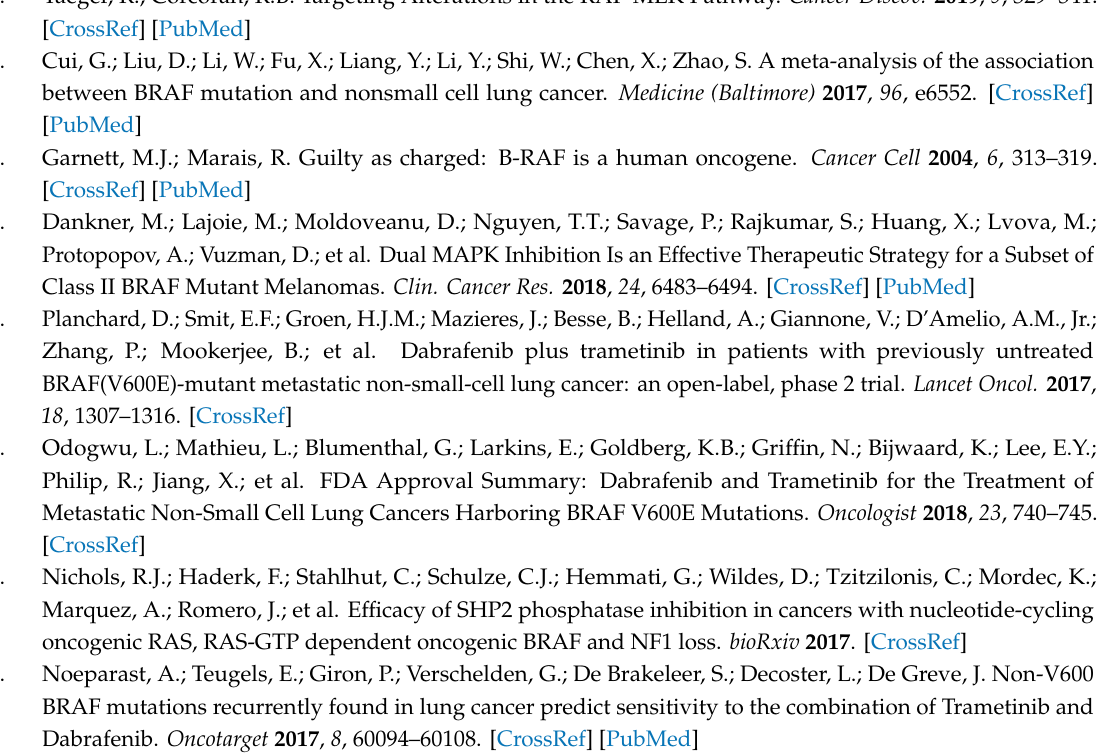
Figure S1: MTT viability assays with IC 50s of SHP2 inhibitors SHP099 and RMC-4550 in the class II and class III cell lines, Figure S2: MTT cell viability assays combining either a BRAF (dabrafenib) or a MEK inhibitor (trametinib) with an SHP2 inhibitor (RMC-4550) in the class II and class III cell